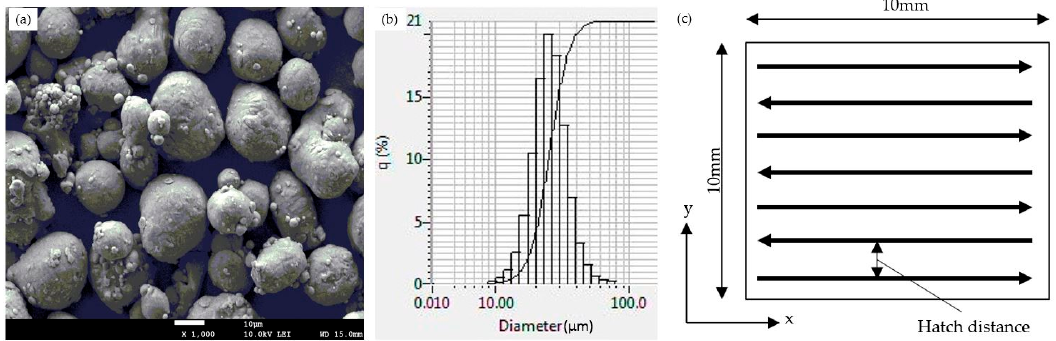
Table 1. Technical parameters of the selective laser melting (SLM) MetalSys 150.